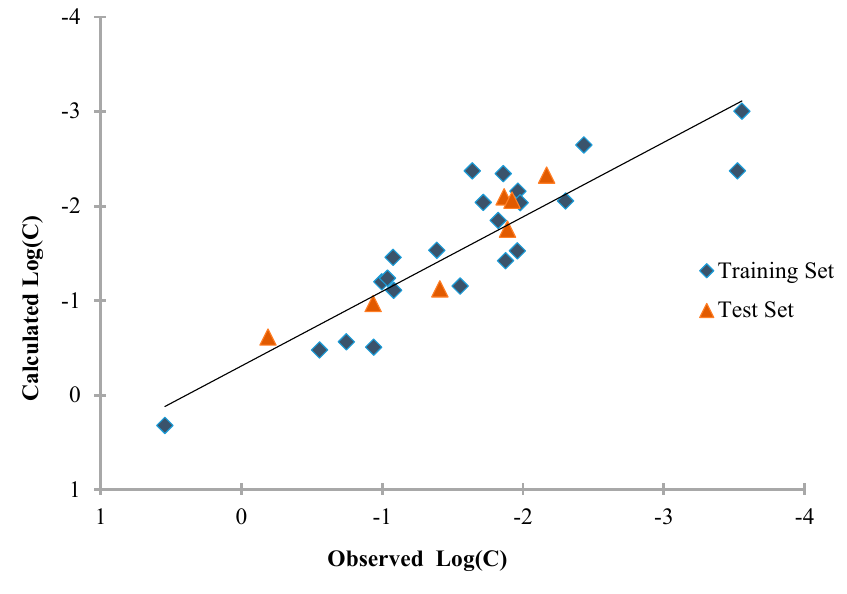
Figure 4. A plot of observed and predicted LogC max values for the entire set (29 compounds) calculated by the 4-variable